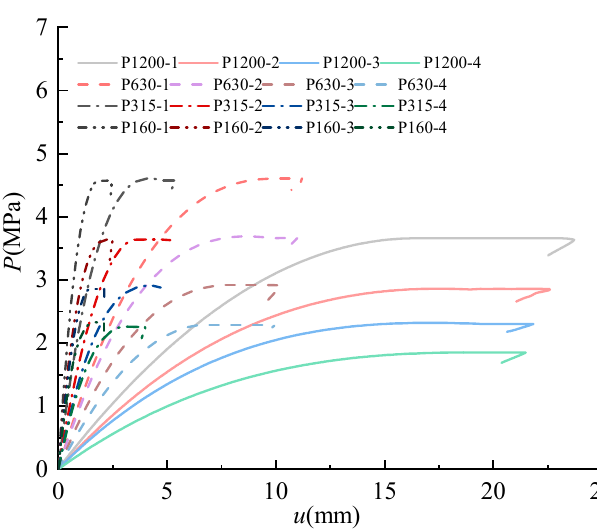
Figure 16. Pressure–displacement curve in burst process.